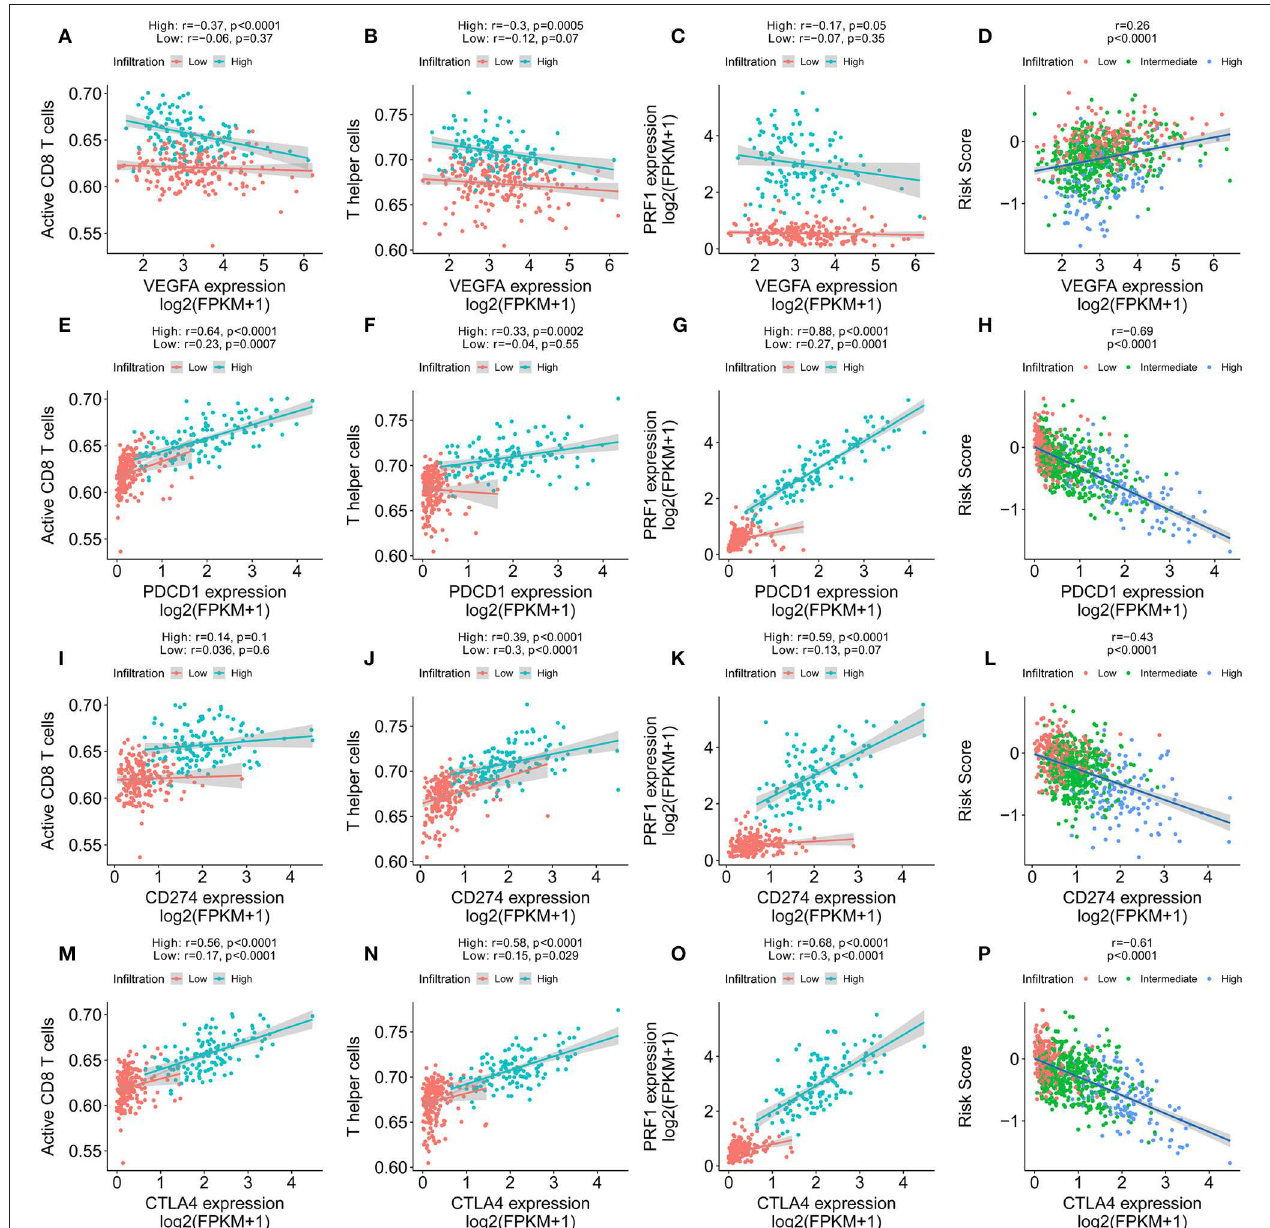
FIGURE 8 | Immune signature predicts immunotherapeutic benefits. (A–C) The correlation of VEGFA expression with T cell infiltration, Th1 cells, and PRF1 expression in high and low immune infiltration conditions. (D) The correlation of VEGFA expression with the immune signature. (E–G) The correlation of PD-1 expression with T cell infiltration, Th1 cells, and PRF1 expression in high and low immune infiltration conditions. (H) The correlation of PD-1 expression with the immune signature. (I–K) The correlation of PDL-1 expression with T cell infiltration, Th1 cells, and PRF1 expression in high and low immune infiltration conditions. (L) The correlation of PDL-1 expression with the immune signature. (M–O) The correlation of CTLA-4 expression with T cell infiltration, Th1 cells, and PRF1 expression in high and low immune infiltration conditions. (P) The correlation of CTLA-4 expression with the immune signature.